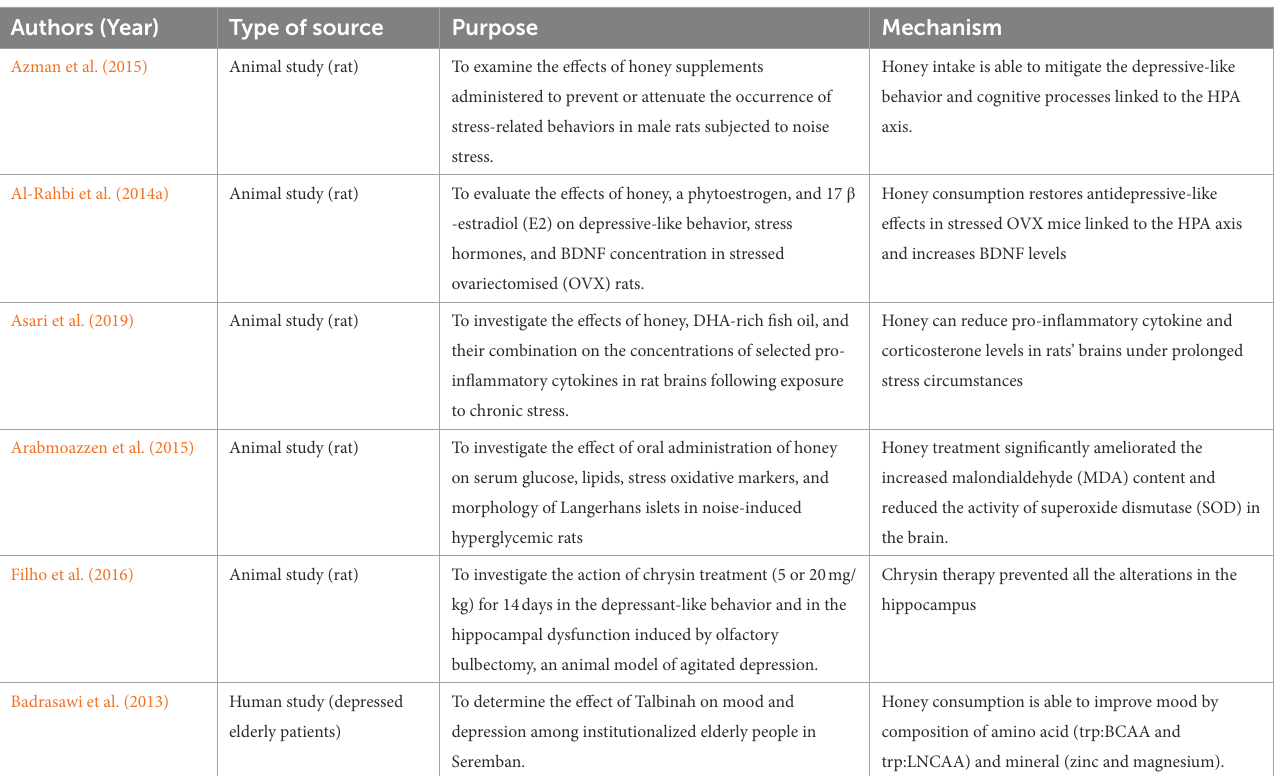
TABLE 4 Anti-stress or anti-depressive effects of honey supplementation on animal